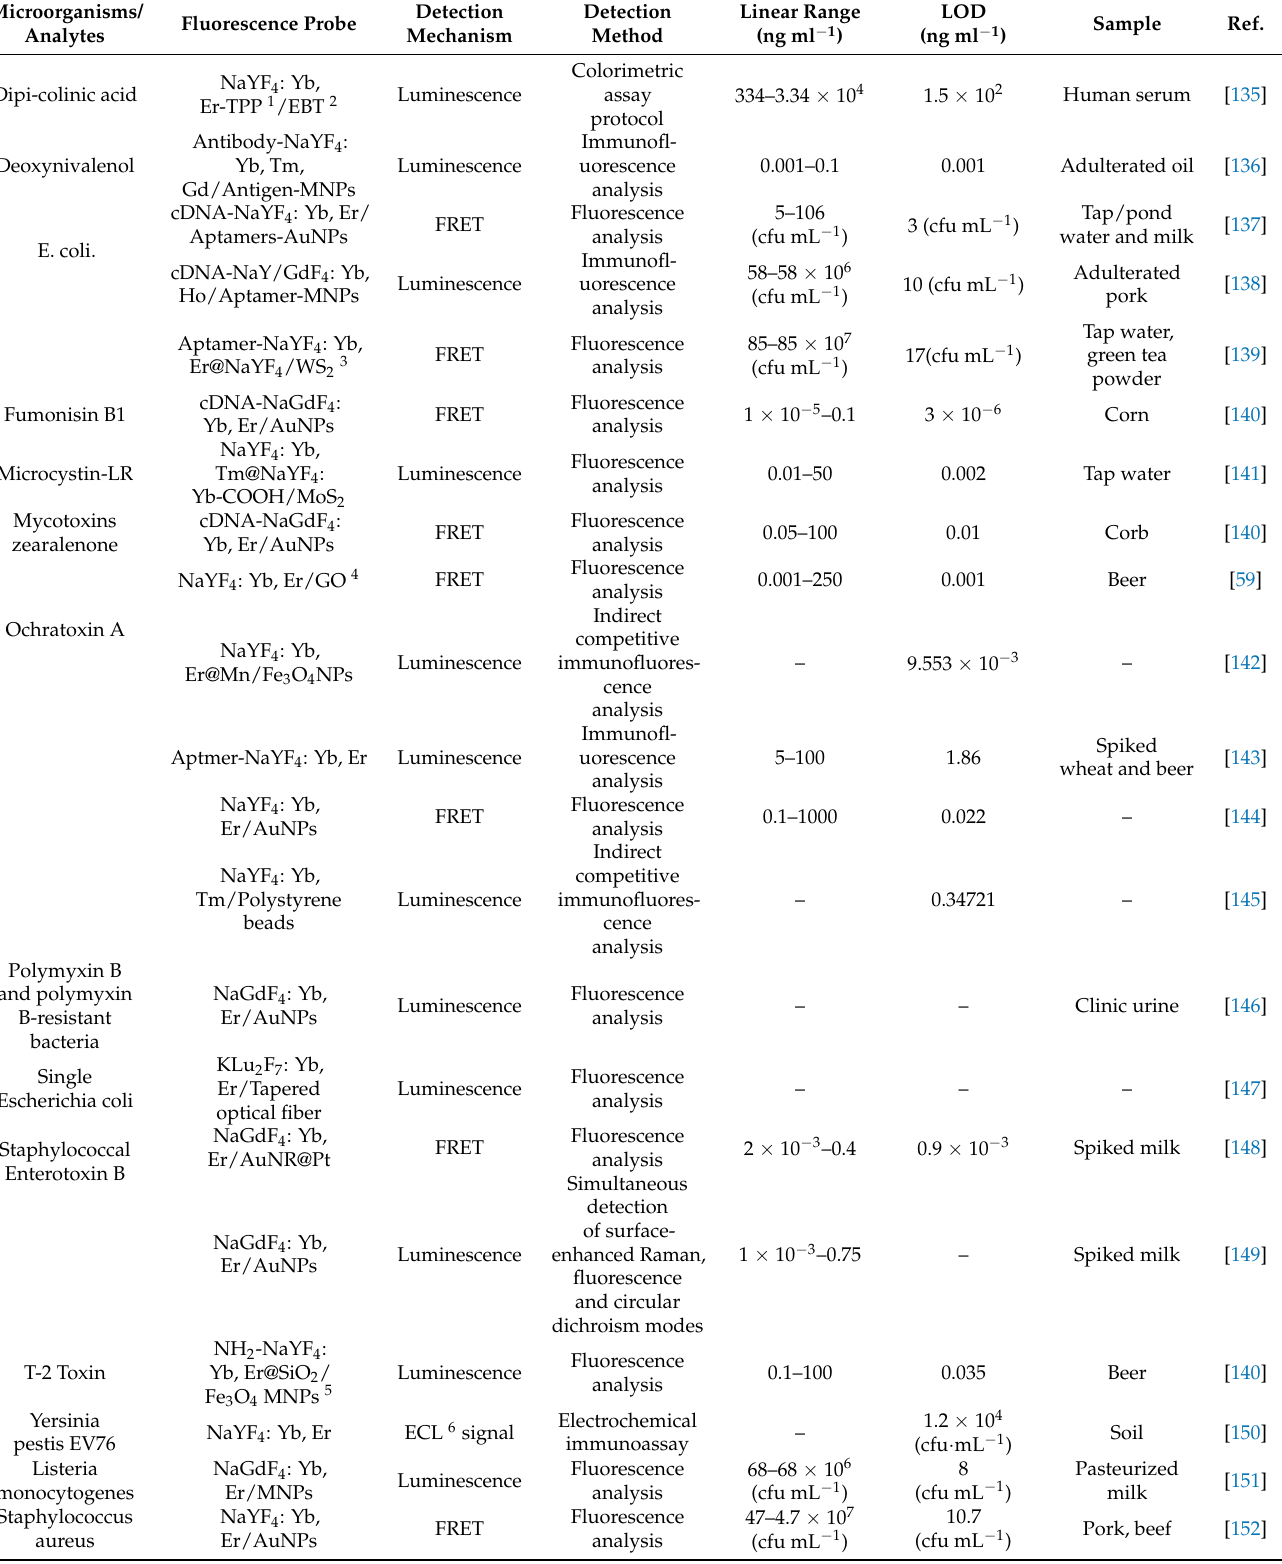
Table 5. Microorganisms analyzed by the UCNPs nanoplatform in the last five years. Microorganisms/